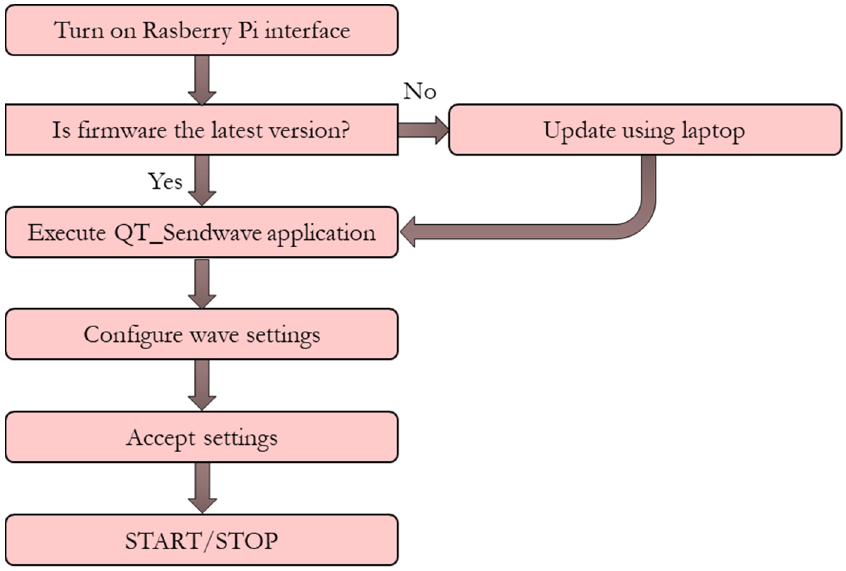
Figure 7. Flow diagram of the software operation.